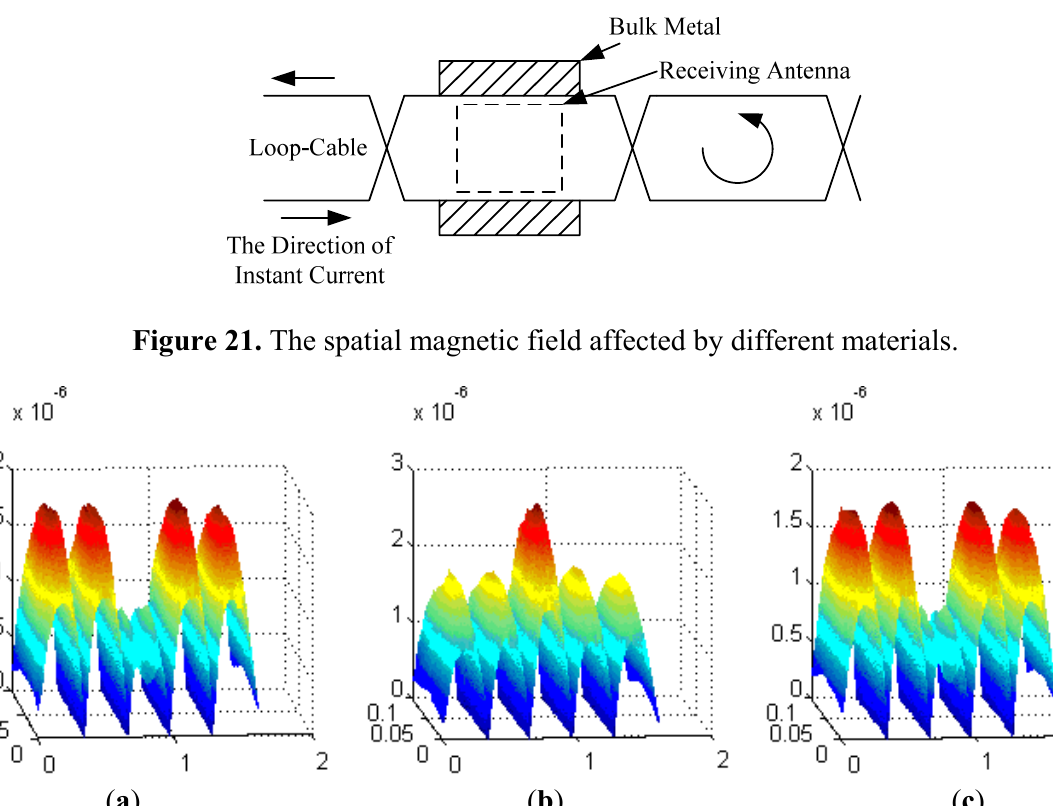
Figure 20. The relative position of bulk metal and loop-cable.